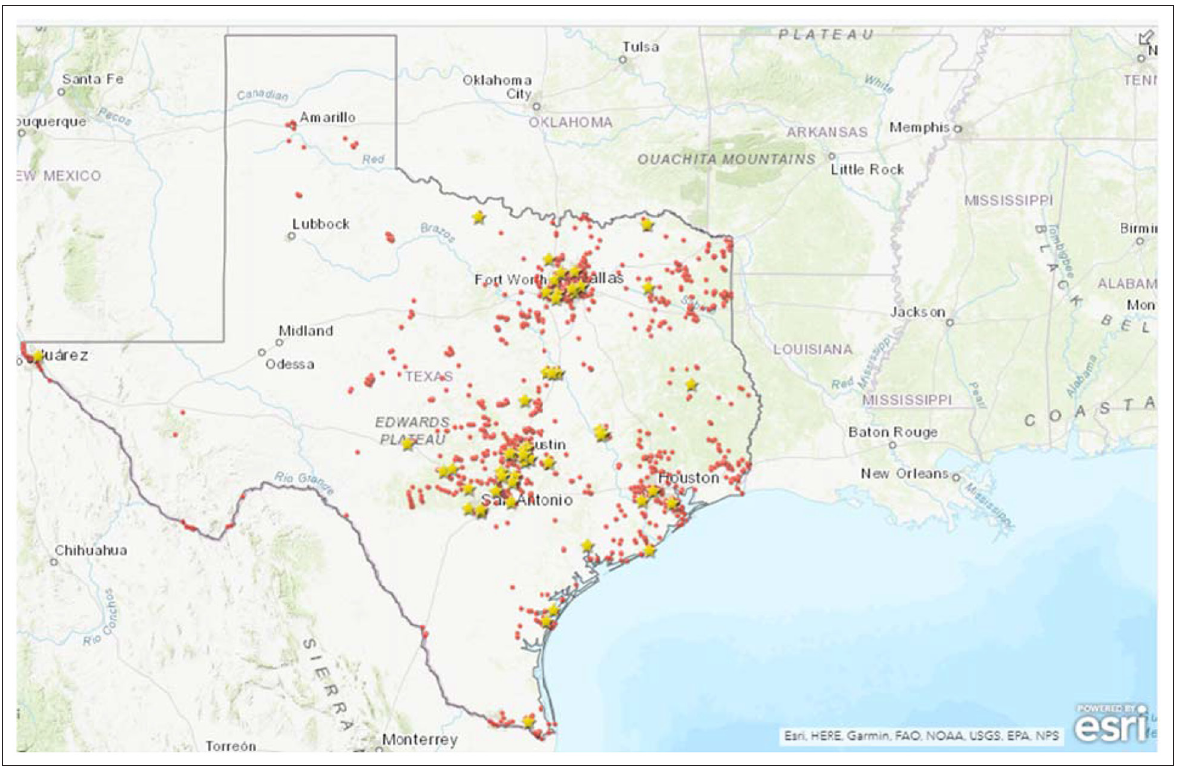
Figure 2 The state of Texas (USA), showing locations of the citizen science volunteer water quality monitoring testing sites ( red circles ) (n = 1,459) and subgroup locations ( yellow stars ) (n =